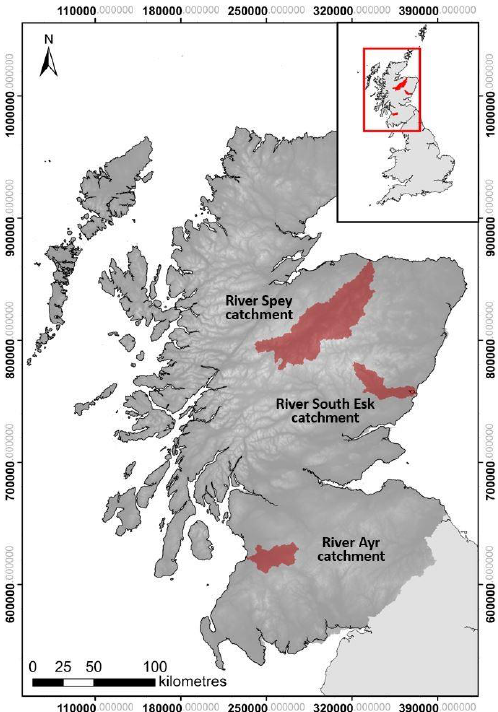
Figure 1. Location of the three study catchments in Scotland, UK. The Ayr catchment is characterised as an agricultural (and particularly a dairy) catch- ment, while the Spey is more of a recreation-focused catchment partly within a